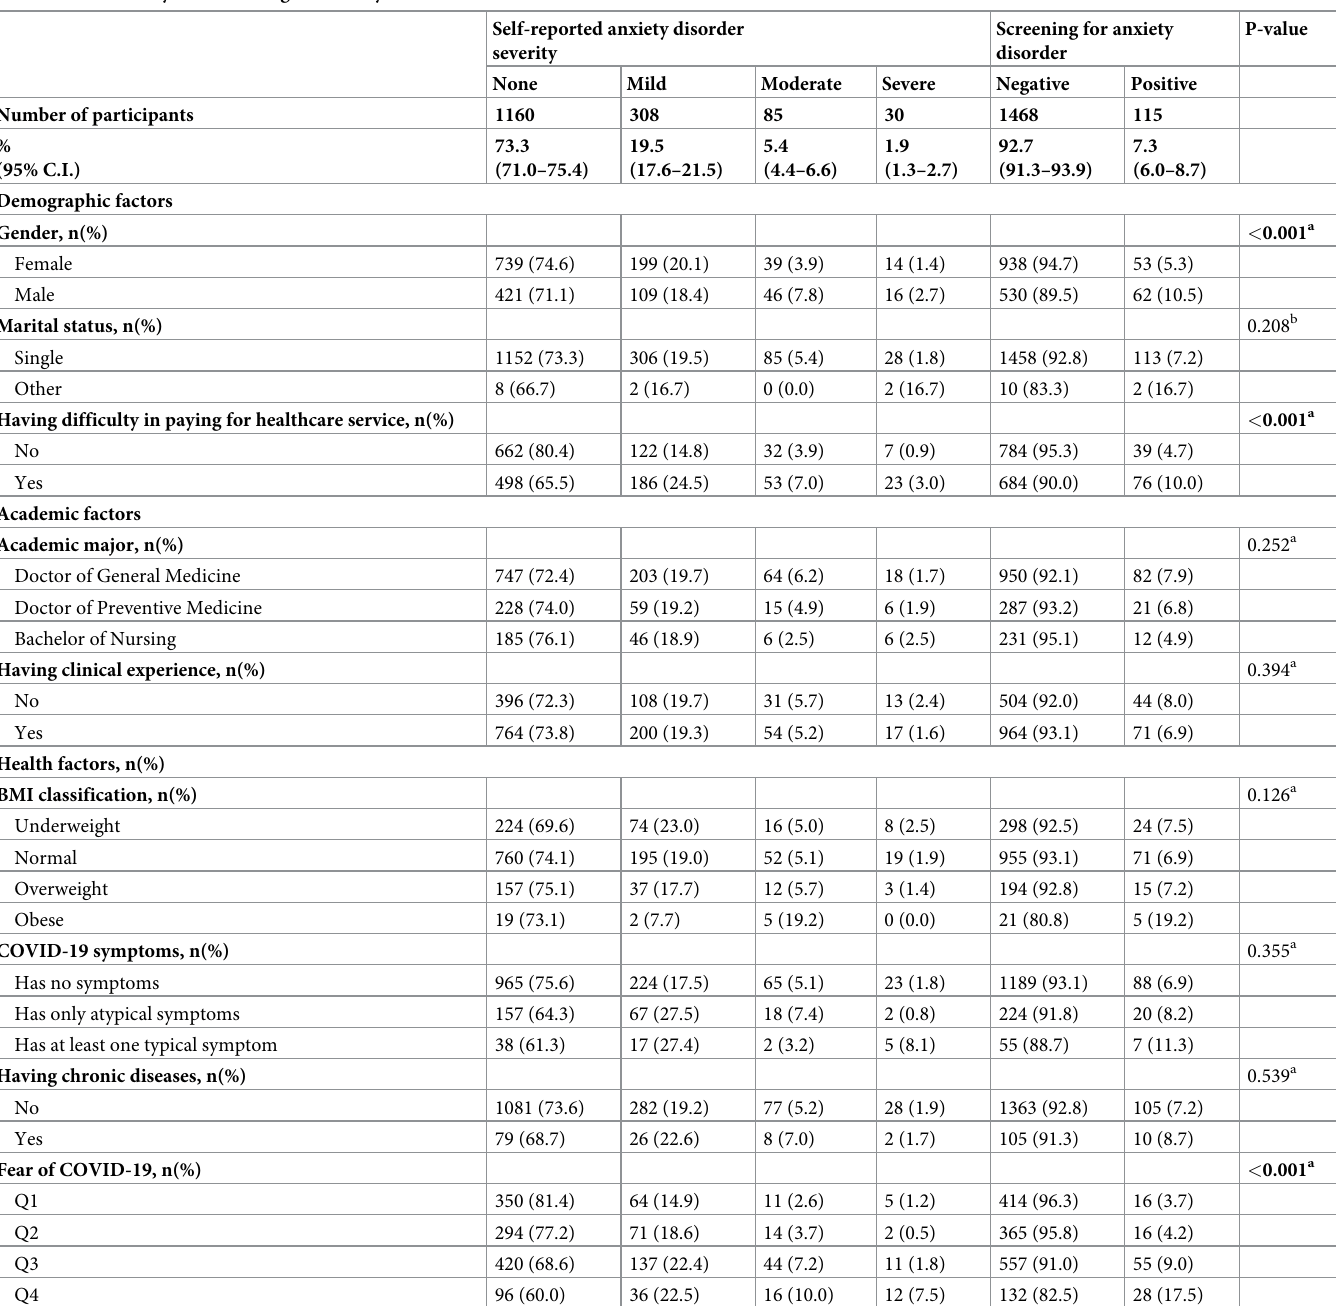
Table 2. The severity and screening for anxiety